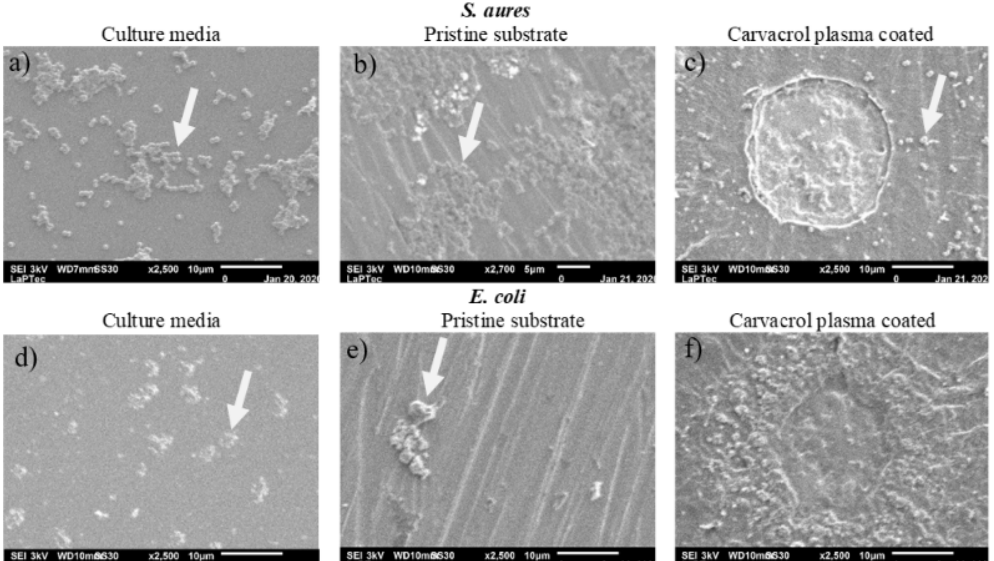
Figure 7. Scanning electron micrographs of colony forming units (CFUs) of S. aureus and E. coli on culture media (( a , d ), respectively) as well as on stainless steel samples as-received (( b , e ) for S. aureus and E. coli , respectively) and coated with plasma deposited carvacrol films (( c , f ) for S. aureus and E. coli , respectively). The arrows indicate the bacterial colonies.